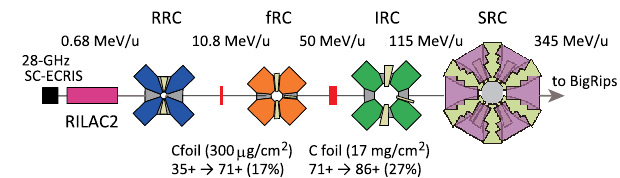
FIG. 1. Uranium beam acceleration scheme at the RIBF. U 35 þ beams extracted from the 28-GHz ECRIS are accelerated to 0 : 68 MeV = u using RILAC2 and are then fed into the RRC. The beams are accelerated to 10 : 75 MeV = u in the RRC and then go through the first carbon-foil stripper ( 0 : 3 mg = cm 2 ). A stripping efficiency of approximately 17% can be reached by selecting the charge state U 71 þ . After the acceleration to 50 MeV = u using the fRC, the charge state of the beams is converted using a second thick carbon-foil stripper ( 17 mg = cm 2 ). The selected charge state, U 86 þ , is obtained with an efficiency of approximately 27%. The U 86 þ beams are subsequently accelerated to an energy of 345 MeV = u using the IRC and SRC. Finally, the beams are delivered to the in-flight RI beam generator, BigRIPS